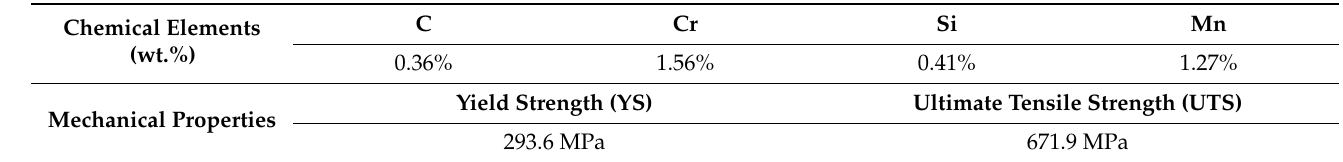
Table 1. Chemical elements and mechanical properties of type 40Cr low alloy